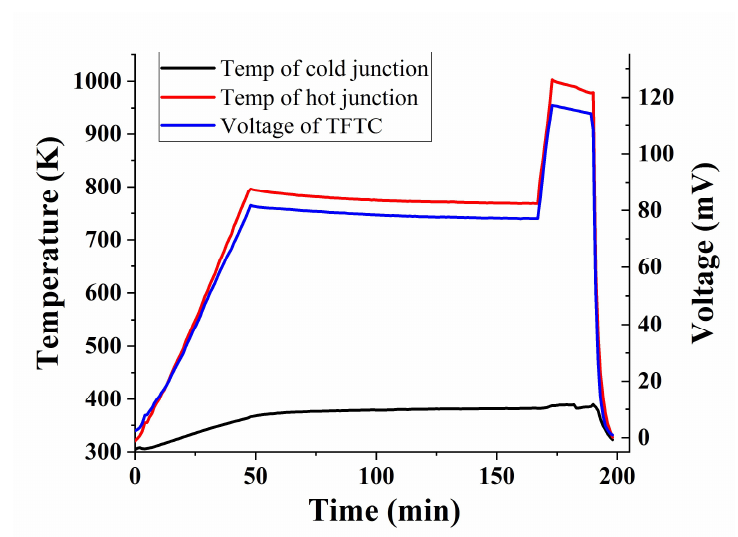
Figure 14. Thermoelectric voltage of WRe26-In 2 O 3 TFTCs.